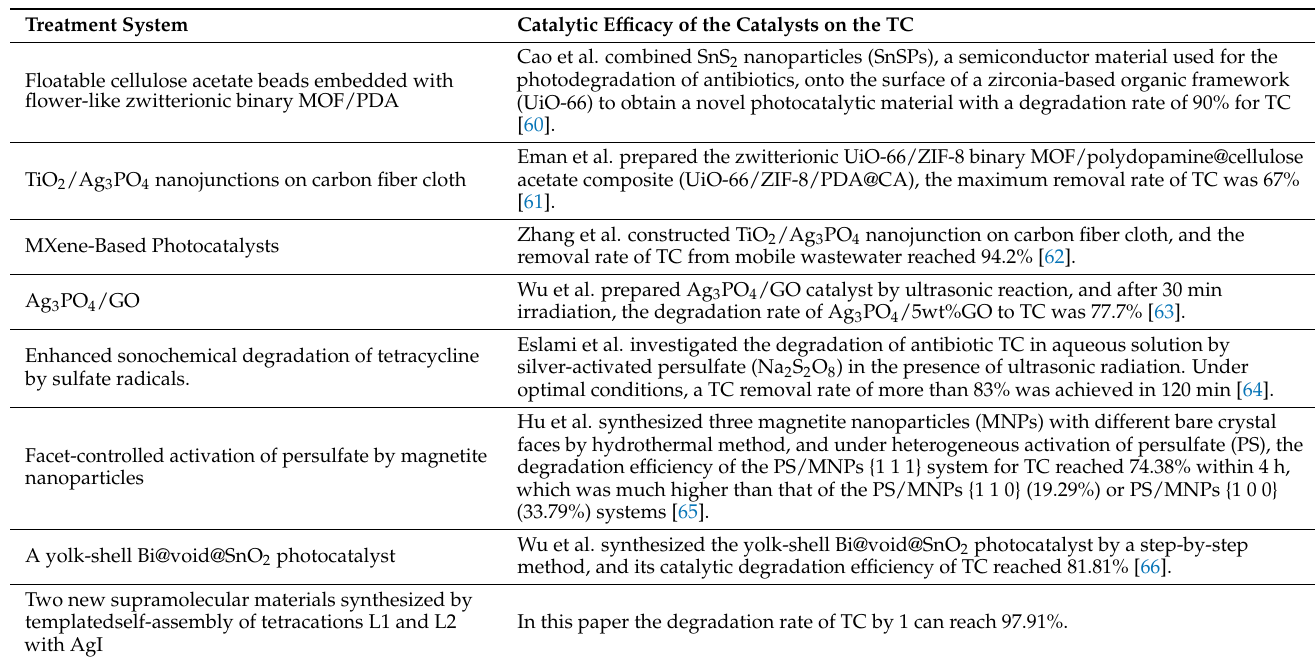
Figure 5. ( a ) The catalytic efficiency of catalysts 1 and 2 on TCs. ( b ) The average removal rate of TC. ( c ) The first-order kinetics of tetracycline degradation by catalysts 1 and 2 . ( d ) The second-order kinetics of tetracycline degradation by catalysts 1 and 2 . Table 2. Degradation effect of different catalysts on